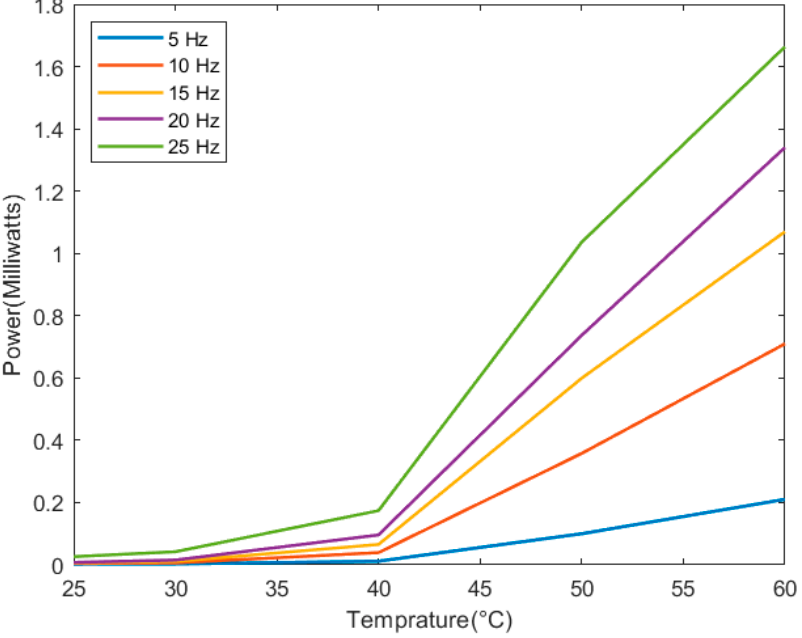
Figure 7. RMS (root mean square) power obtained in the function of temperature and